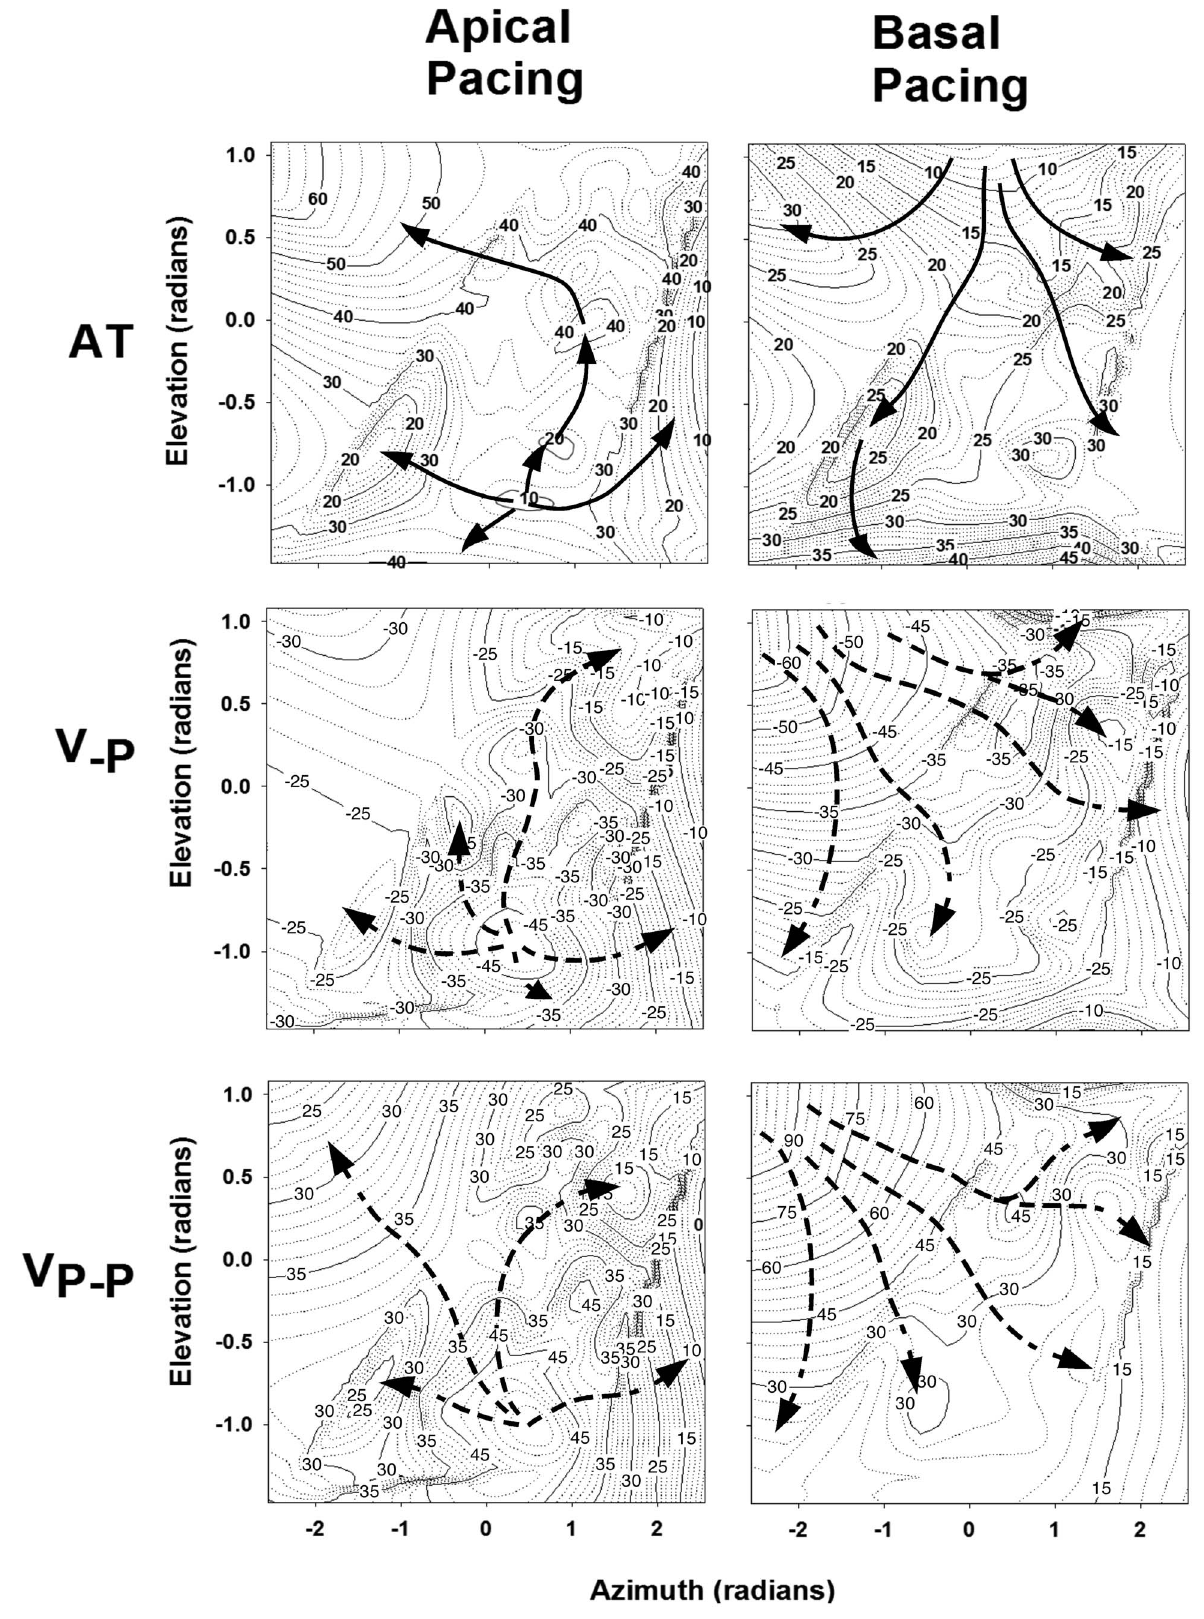
Figure 4. Spatial representation of sub-endocardial electrogram parameters during sub-endocardial pacing from the apex (left panels) and base of the left ventricle (right panels). Two dimensional space is based on spherical coordinates derived from needle locations, representing elevation ( 2 1= apex to + 1= base), and azimuth ( 2 2= mid lateral to + 2= anterior). Numbered contours represent parameters derived PLOS ONE |